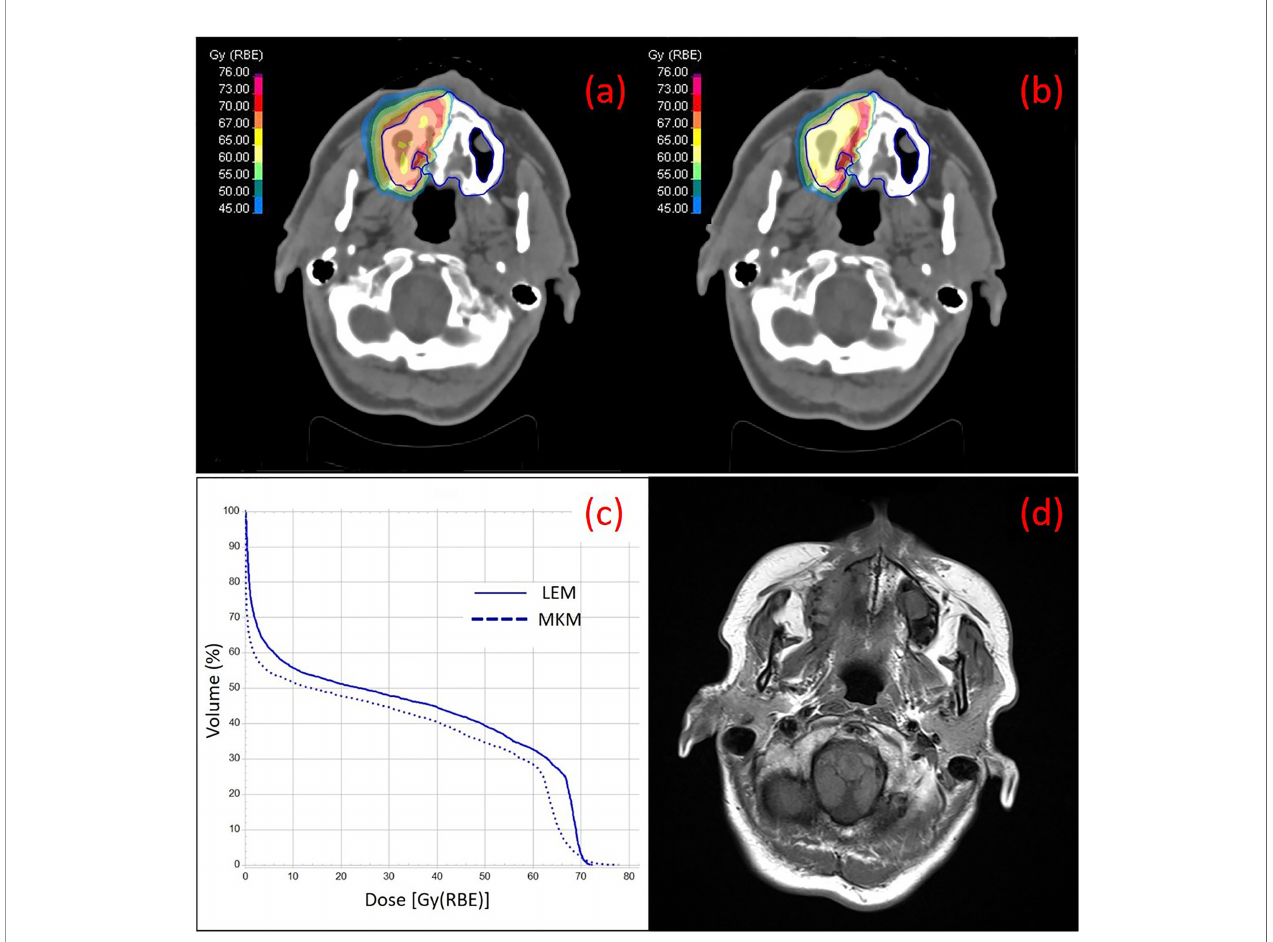
FIGURE 1 | Treatment plans on the simulation CT of one of the patients of the series with ACC at the right nasal cavity with color wash of the most representative isodoses at the maxilla (contoured in blue), calculated with LEM (A) and MKM (B) radiobiological model, are shown. The irradiation geometry consisted of 2 beam ports with couch rotation of 165°C and 180°C. In (C) the DVH curves for the maxilla calculated with LEM and MKM are depicted. In (D) a T1-weighted axial image taken from the 2 years post-CIRT MRI of the same patient is depicted with typical imaging features of maxillary Grade 1 necrosis.